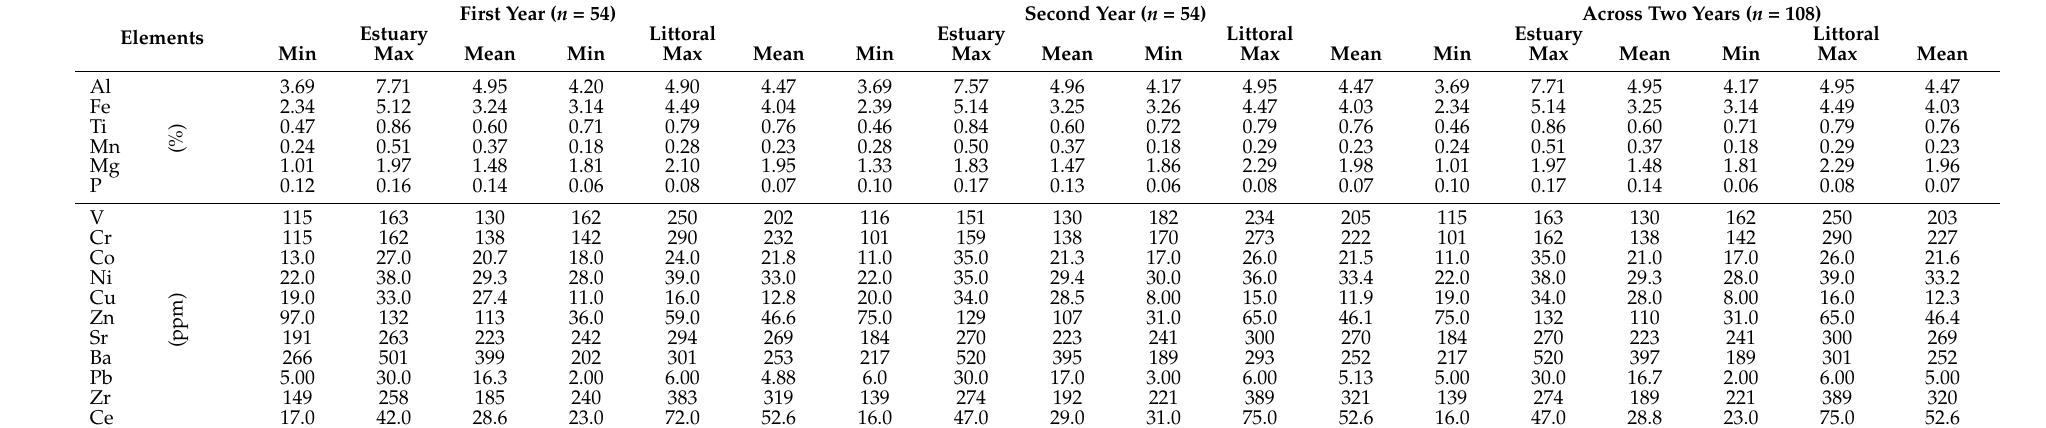
Table 2. Statistical description of elements concentrations (ppm), except Al, Fe, Ti, Mn, P, and Mg in %.